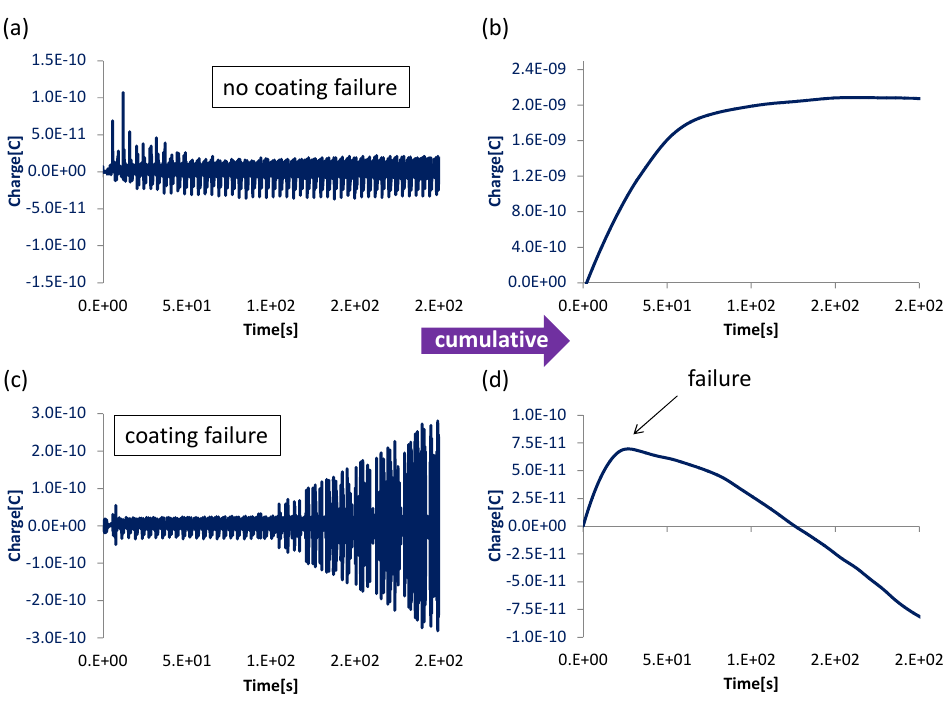
Figure 8. Surface charge vs. time: ( a ) no coating failure—instantaneous; ( b ) no coating failure—cumulative; ( c ) coating failure—instantaneous; ( d ) coating failure—cumulative.